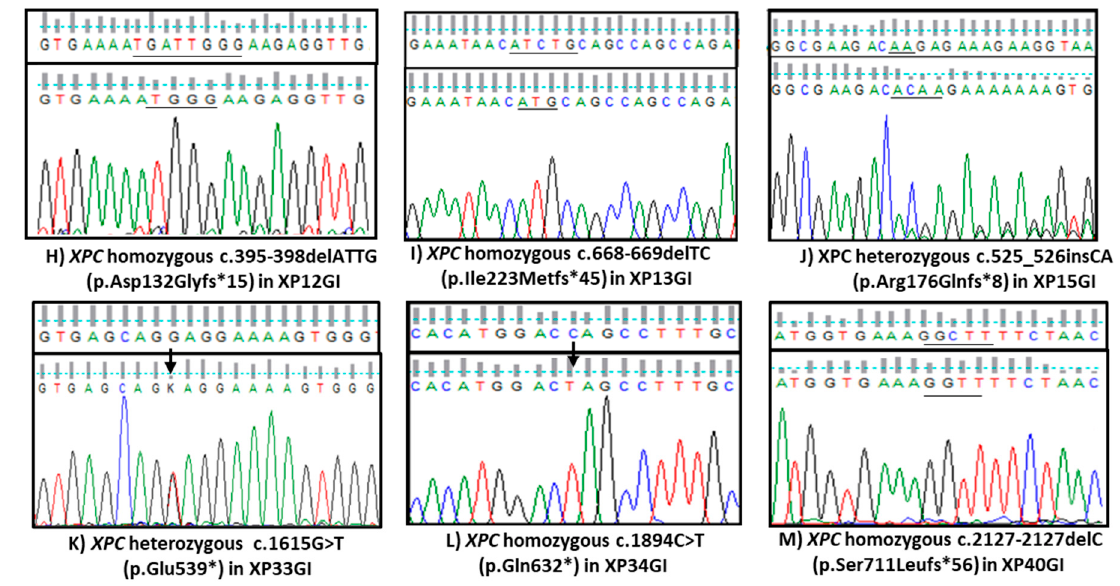
Figure 2. Sequencing chromatograms of XPA and XPC mutations identified in our cohort. The figure shows three previously reported XPA (NM_000380.3) mutations ( A – C ), four previously reported XPC (NM_004628.4) mutations ( D – G ), and six novel XPC mutations ( H – M ). Wildtype sequences are shown above each chromatogram, deletions and insertions are underlined for illustration, and black arrows point towards single base changes. In ( G ), the change at ( − 6) is a benign single nucleotide polymorphism (SNP; rs2279017).